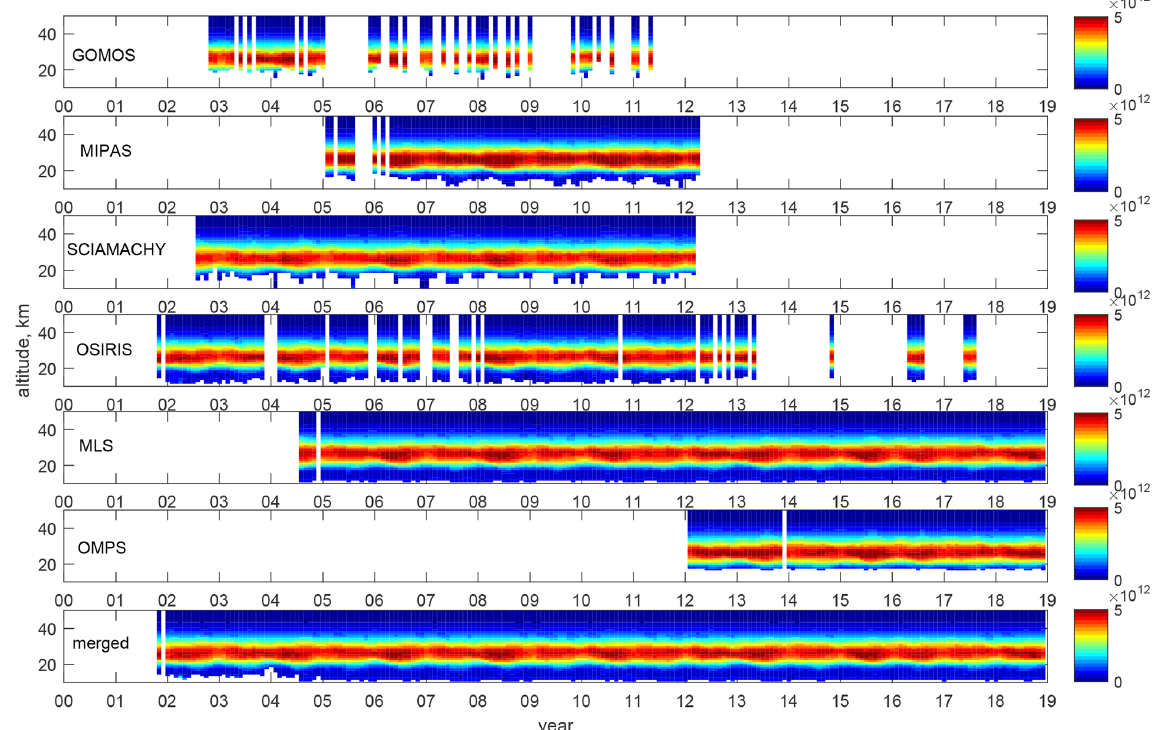
Figure 8. An example of number density ozone profiles (in cm − 3 ) for individual instruments and the merged dataset in the spatial bin